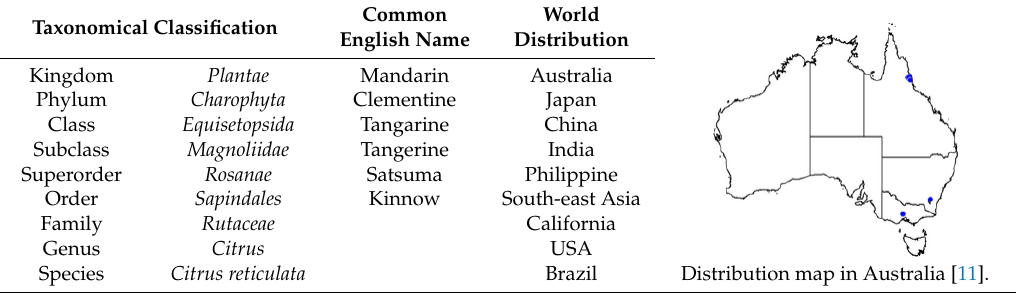
Table 1. Taxonomical classification, common names and distribution of Mandarin in Australia. Taxonomical Classification